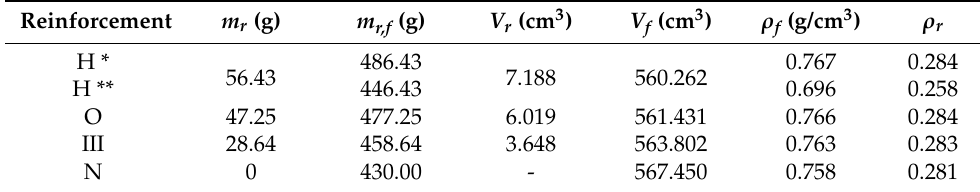
Table 1. Mean values of mass, volume and densities .